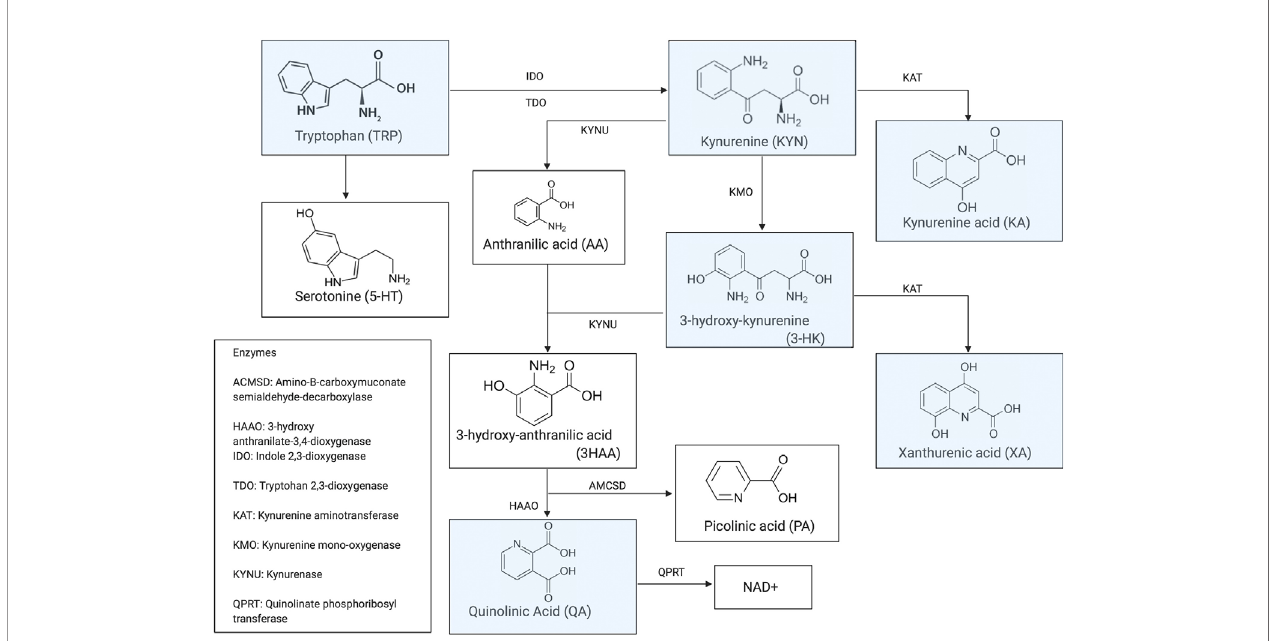
FIGURE 1 | Kynurenine Pathway [previously published in Morrens et al.